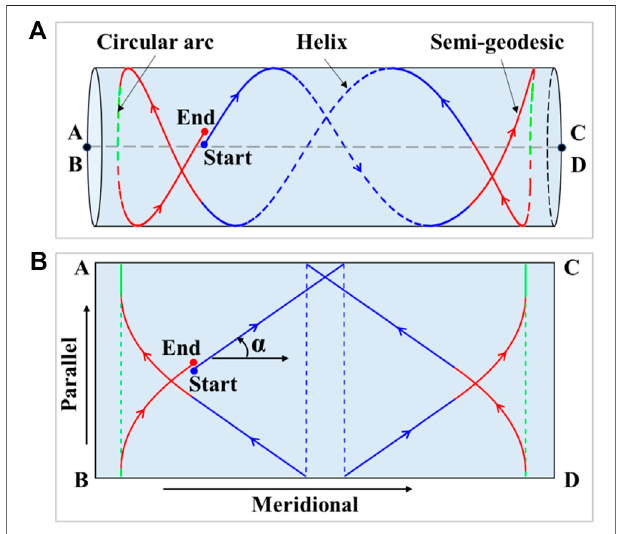
FIGURE2|(A) Yarncenterlinealongonecycleonthecylindricalsurface; (B) yarn centerline along one cycle after the cylindrical surface is spread.